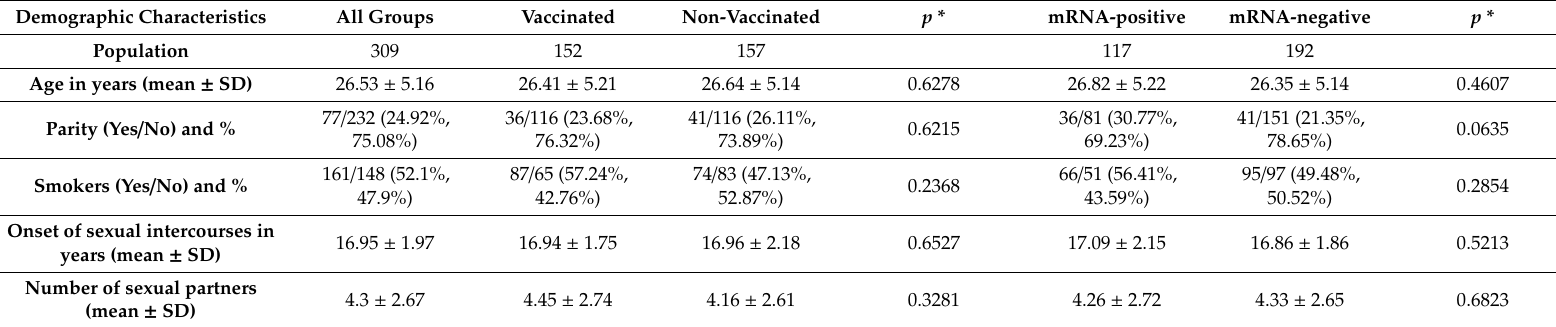
Table 2. Demographic characteristics of the studied population, comparison between the vaccinated and non-vaccinated women and comparison between the HPV mRNA-positive and mRNA-negative women (all the individuals listed in this Table tested HPV DNA-positive at recruitment). SD: standard